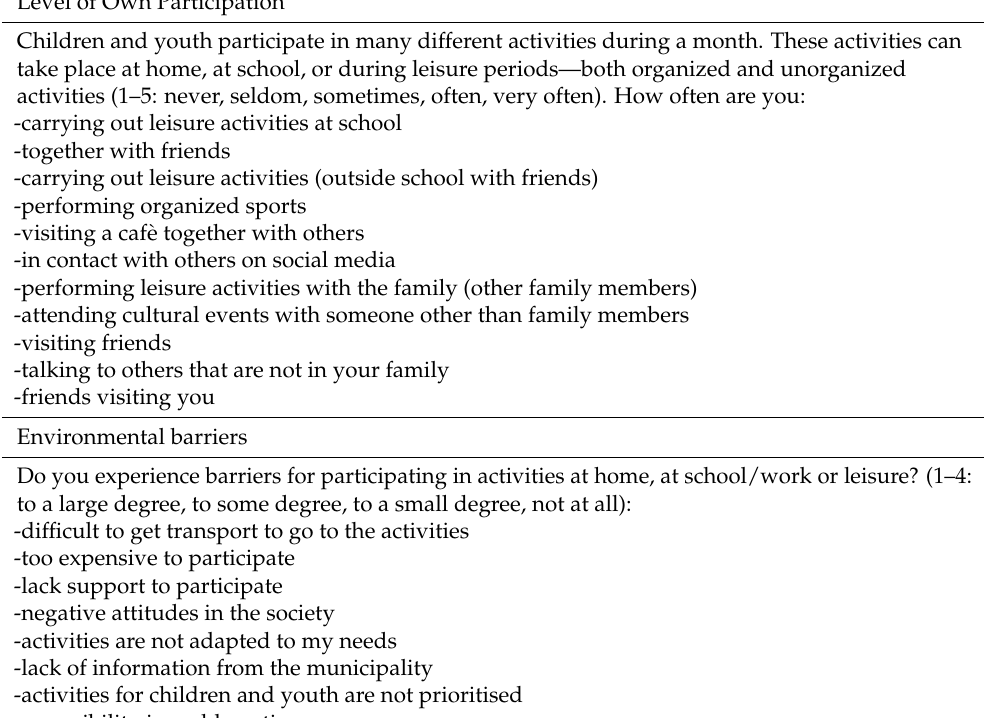
Table 2. Participation scale